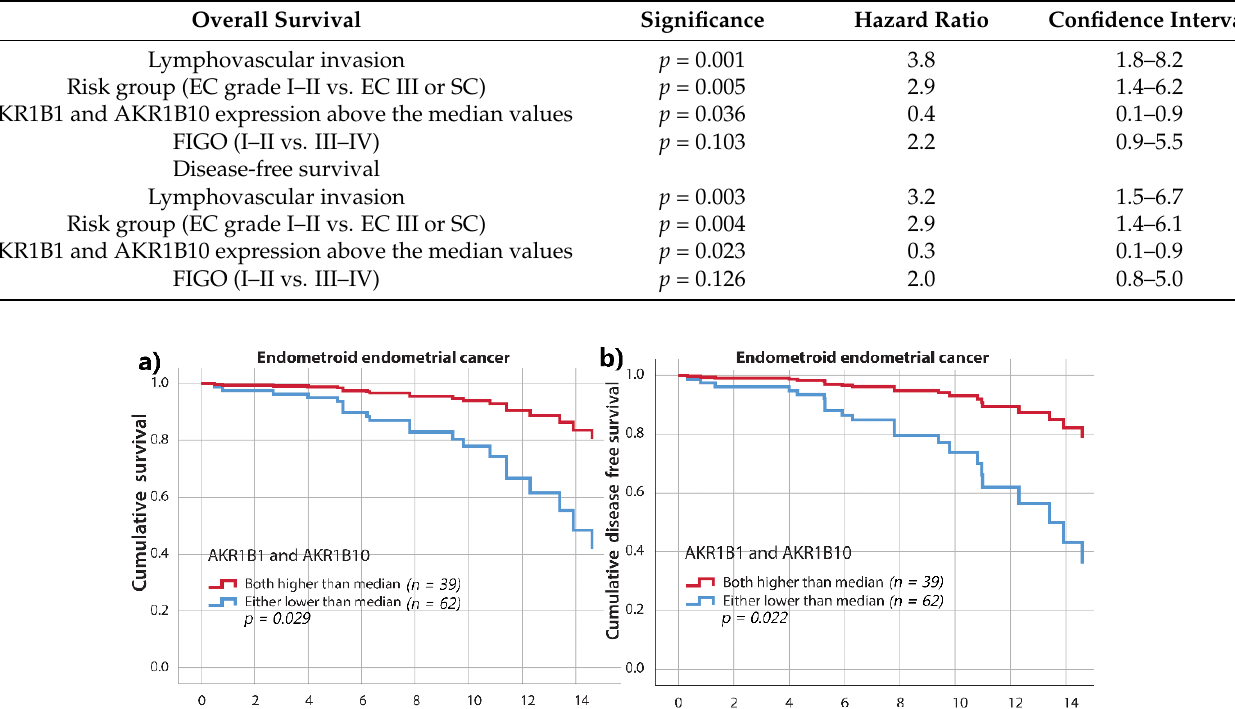
Table 3. Data on multivariant analysis of independent factors predictive of survival.